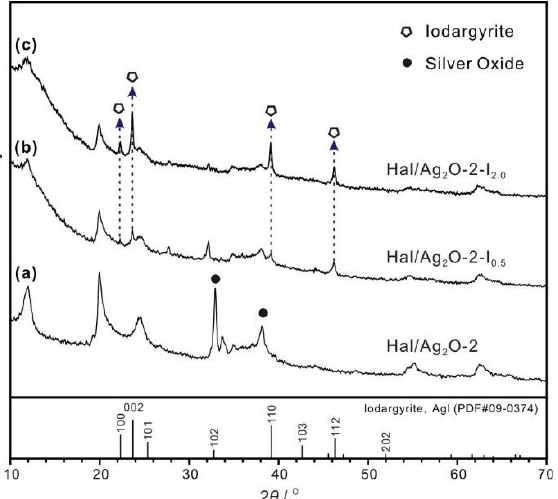
Figure 5. XRD patterns of ( a ) Hal/Ag 2 O-2 and ( b,c ) Hal/Ag 2 O-2 after adsorption of I – at different concentrations.